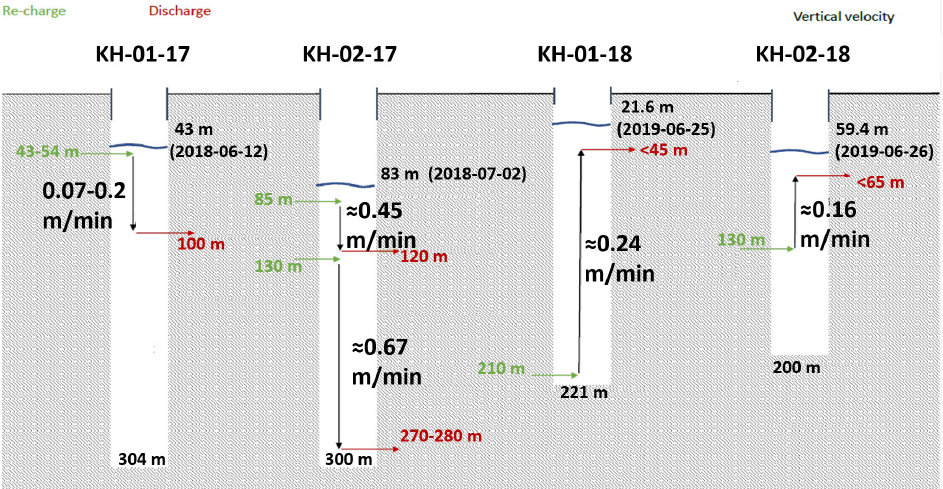
Figure 3. Sketch summarising the results for vertical groundwater flow (modified after Acuña et al. (2020), fig. 9). The borehole names and depths are written above and below each borehole, respectively. The groundwater levels are indicated by blue lines. Depths where water enters through fractures are given by green text and arrows, and depths where groundwater leaves the borehole through fractures are given by red text and arrows. The velocity of the vertical groundwater movement is written with larger, black